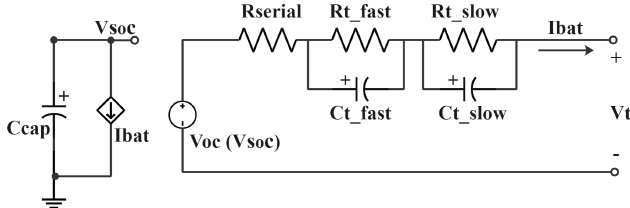
Figure 9. Equivalent electrical model of the lead–acid battery [61,62].